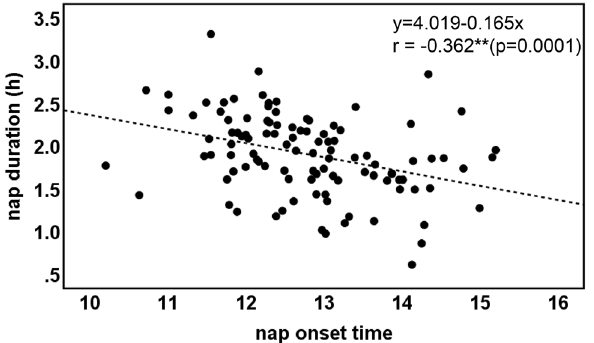
Figure 3. Correlations of nap duration with nap onset time in term toddlers of approximately 1.5 years of age (** p <